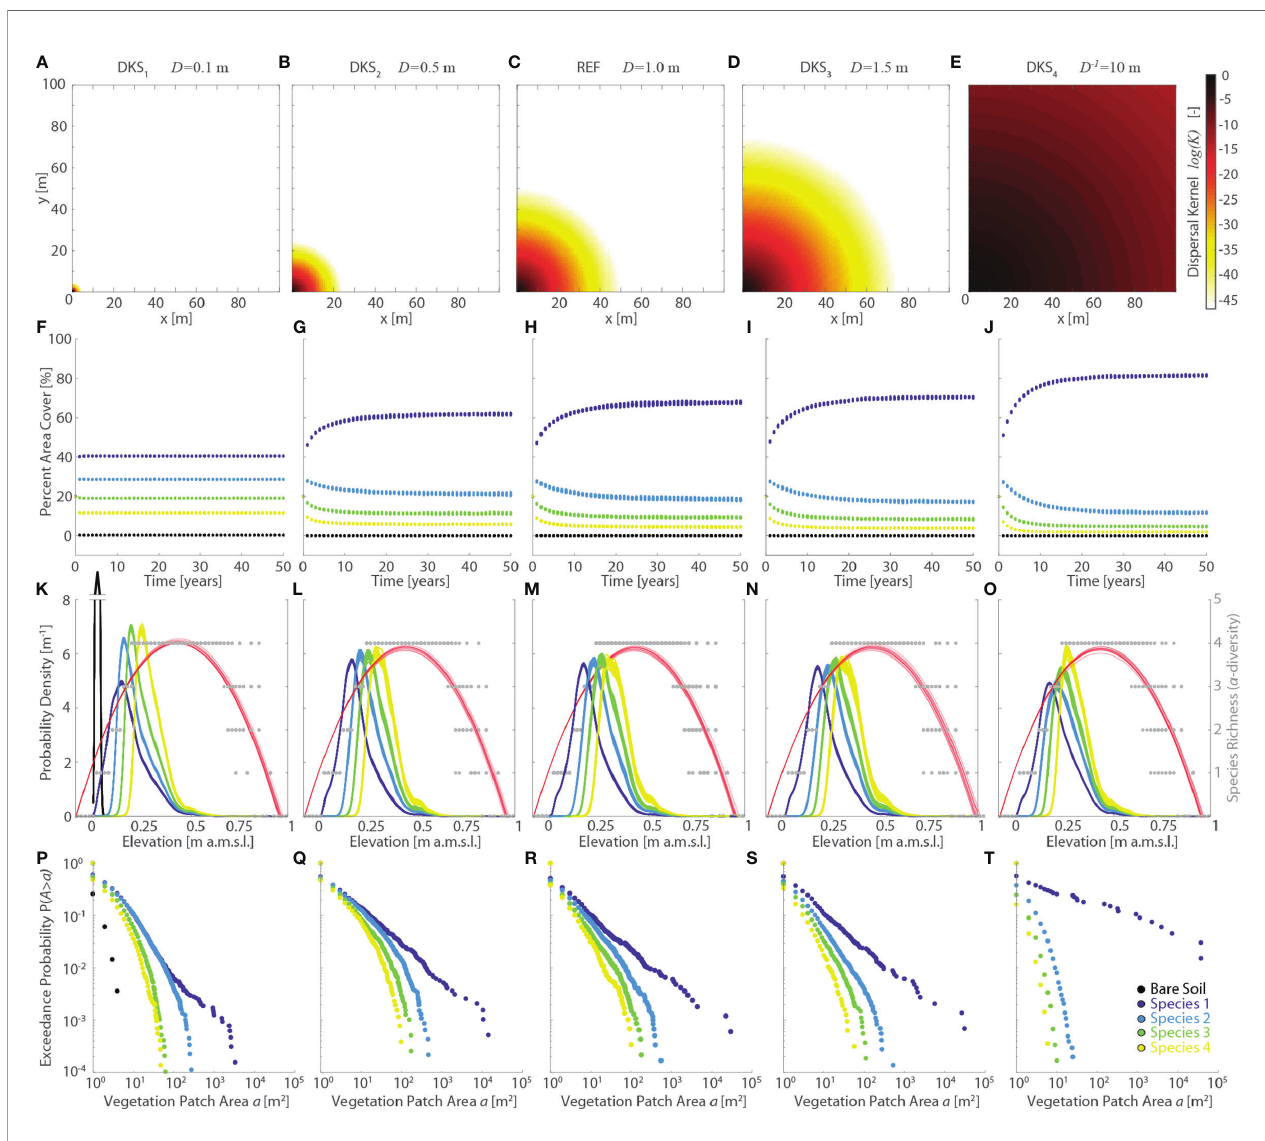
FIGURE 7 | Effects of changes in dispersal kernel size (DKS series, characteristic dispersal length D is assumed to be species-independent). Results of the reference simulation (REF, D = 1 m) are shown in the central column. The fi rst and second columns report respectively the results of the DKS 1 ( D =0.1 m) and DKS 2 ( D = 0.5 m) simulations, whereas the fourth and fi fth columns show the results of the DKS 3 ( D = 1.5 m) and DKS 4 ( D =10 m) simulations, respectively. Each panel displays data derived from all the 20 numerical simulations performed for each scenario. Different colors denote different vegetation species, including bare soil, according to the legend shown in the lower-right panel. (A – E) Representation of the dispersal kernel illustrated in a square, 100m wide, idealized lattice domain. Log-values of the dispersal kernel k are shown as a function of the euclidean distance d of each pixel from the pixel in the lower-left corner within the idealized lattice. (F – J, M) Changes of percent vegetation cover over the whole simulation horizon. (K – O) Realized vegetation niches (left y-axis) and local species richness (i.e., a -diversity, right y-axis) as a function of marsh elevation at the end of the simulation horizon. Gray dots represent a -diversity point data with red lines showing the best quadratic fi t to point data. (P – T) Empirical probability distributions of spatially- continuous vegetation patch areas are shown based on the exceedance probability for a given vegetation patch